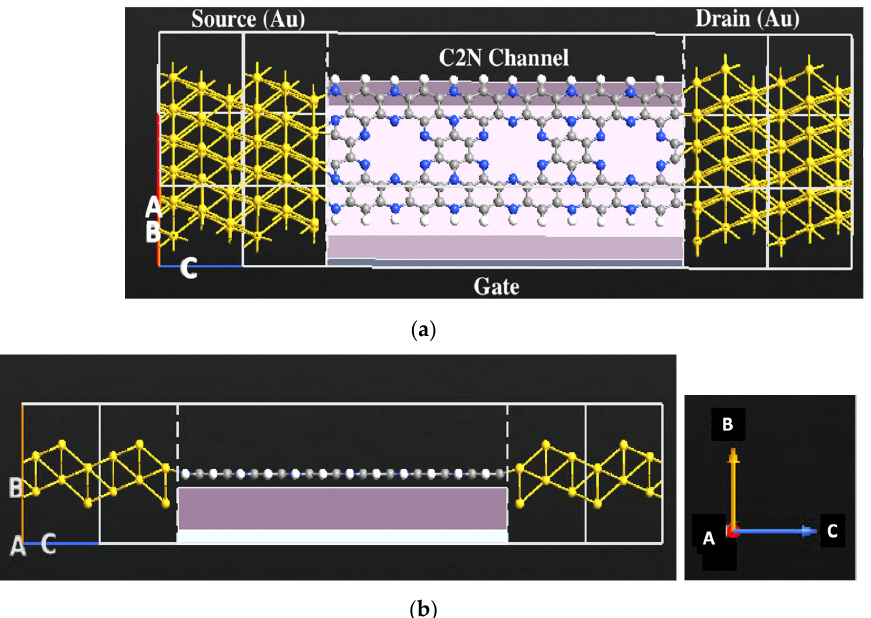
Figure 1. C 2 N-FET sensor designed by ATK-VNL. ( a ) Schematic representation of the C 2 N-FET device. ( b ) Cross-sectional view of the C 2 N-FET device. The built sensor consists of two gold elec- trodes, a monolayer C 2 N channel and a gate underneath the channel. Color code: hydrogen—white, nitrogen—blue, gold—yellow, and carbon—gray.